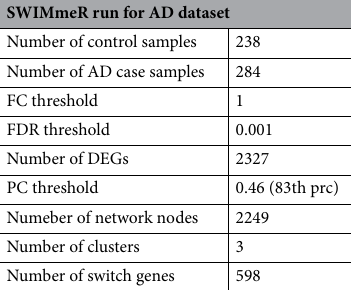
Table 2. Summary of SWIMmeR parameters. AD, Alzheimer’s disease; FC, fold-change; FDR, False Discovery Rate; DEGs, Differentially Expressed Genes; PC, Pearson